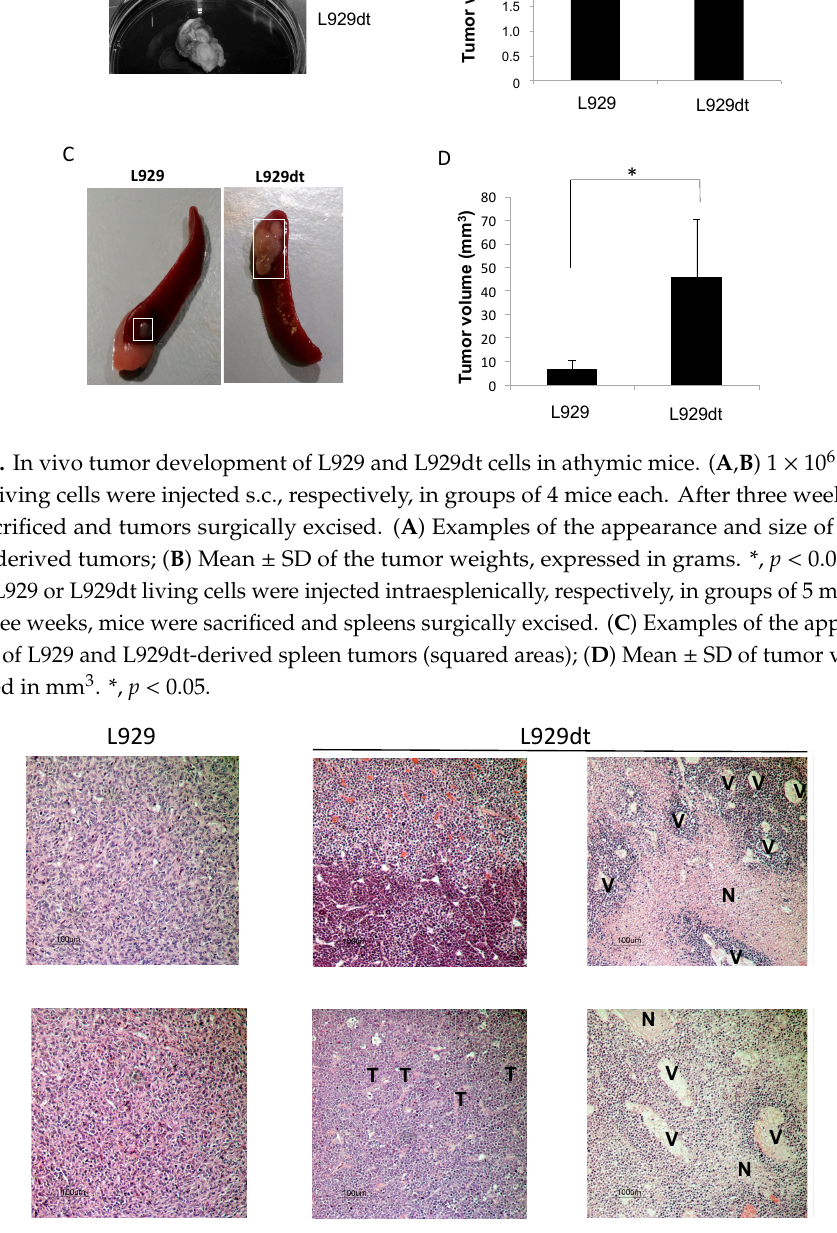
Figure 5. Hematoxilin/eosin staining in histological sections of L929 or L929dt-derived tumors in athymic mice. Paraffin tissue sections were stained with standard H&E coloration, as indicated in Material and Methods. Magnification was 100× in all images. N, necrotic areas; V, vessel-like structures; T, trabecular structures, all detected in L929dt-derived tumors, but not in L929-derived ones.